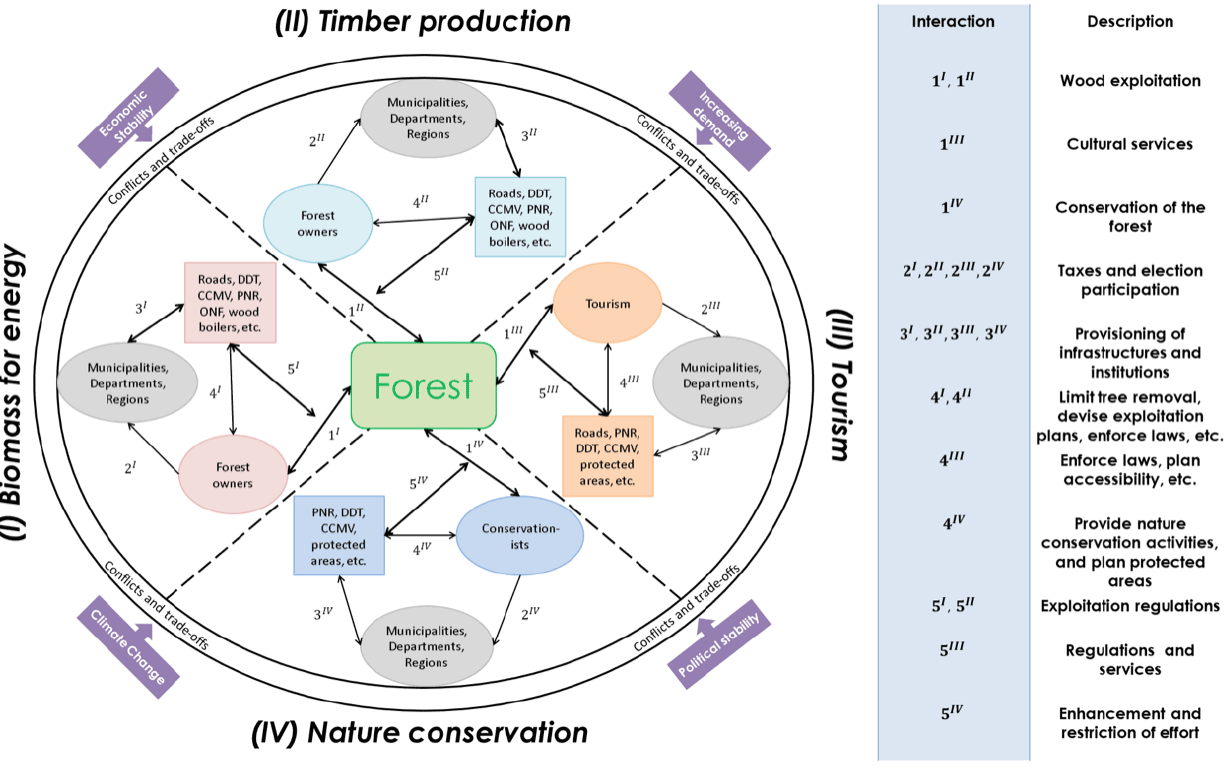
Fig. 5 . Forest functions from the point of view of the robustness framework’s conceptual map. The thicker the arrow, the more important the interaction. Note: DDT = Direction Départementale des Territoire; ONF = Office Nationale des Forêts; CCMV